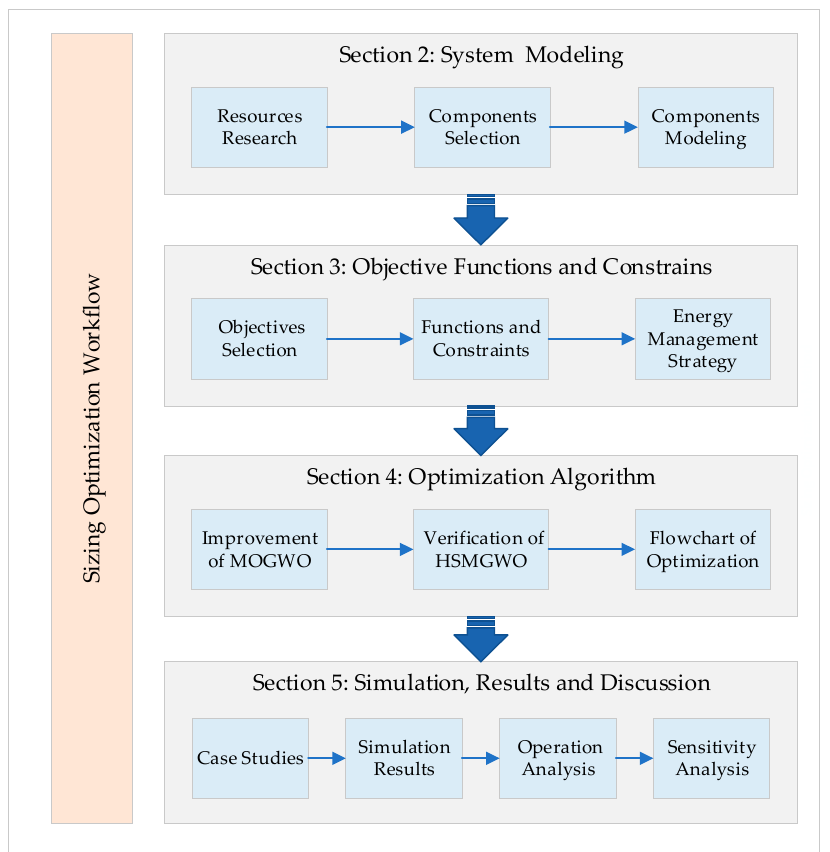
Figure 1. The workflow of this